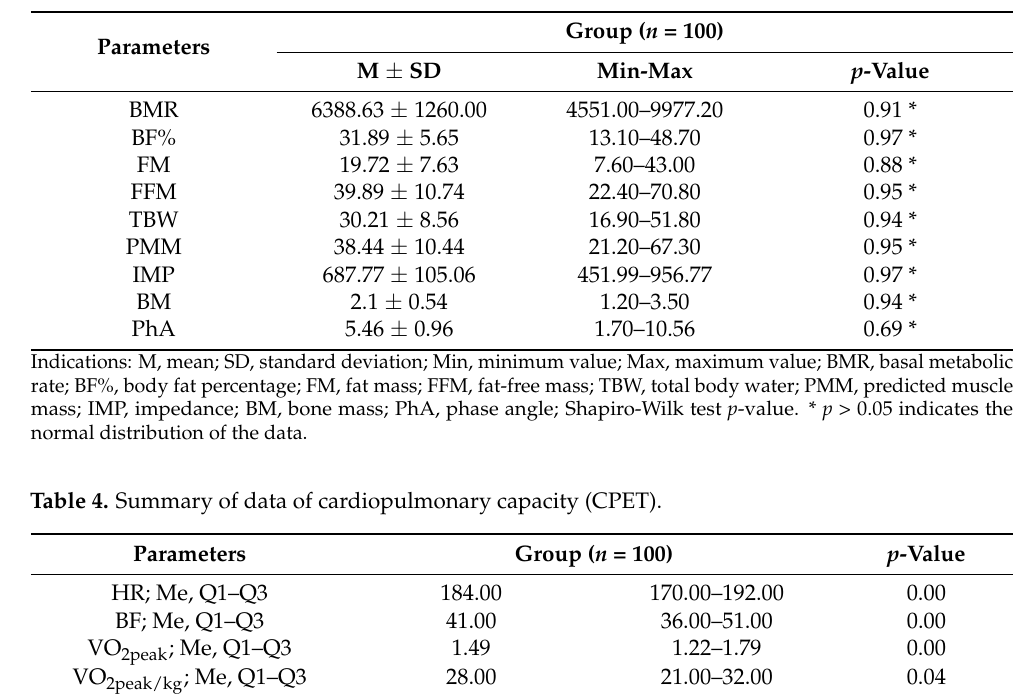
Table 3. Summary of data of body mass composition (Tanita test).